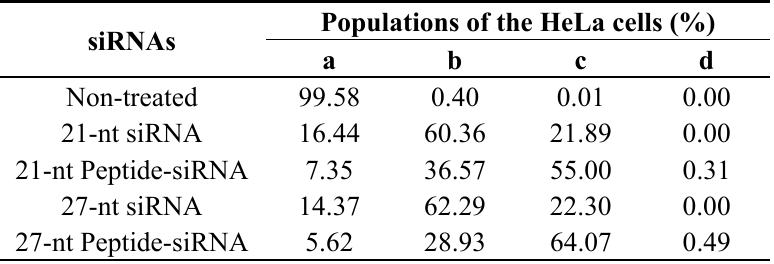
Table 2. Fluorescence-intensity populations ( a – d ) of the HeLa cells treated with siRNAs by flow cytometric